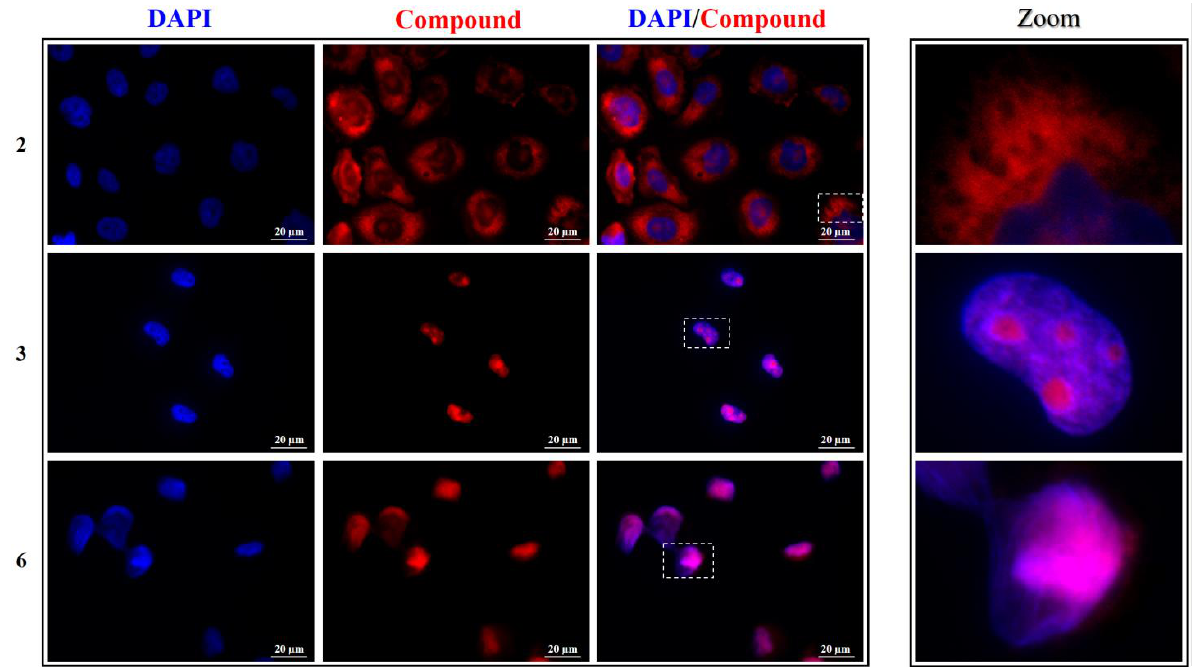
Figure 6. Left panel: representative fluorescence microscopy images of nuclei (DAPI, blue), com- pounds 2 , 3 , and 6 (red), and the relative merged images of HeLa cells. Image magnification: 60×. Right panel: zoom-in of representative cells.